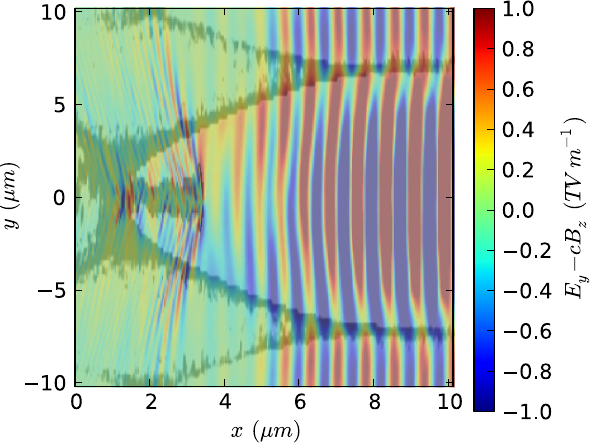
(cid:1) cB FIG. 2. Snapshot of the transverse field E in the x - y y z plane, at the back of the bubble and after 300 (cid:2) m of acceleration. Shaded regions correspond to zones of high electrondensity (in this case the sheath of the bubble and the accelerated bunch). While the laser pulse is clearly apparent on the right-hand side of the figure, one also notices higher-frequency radiation around the